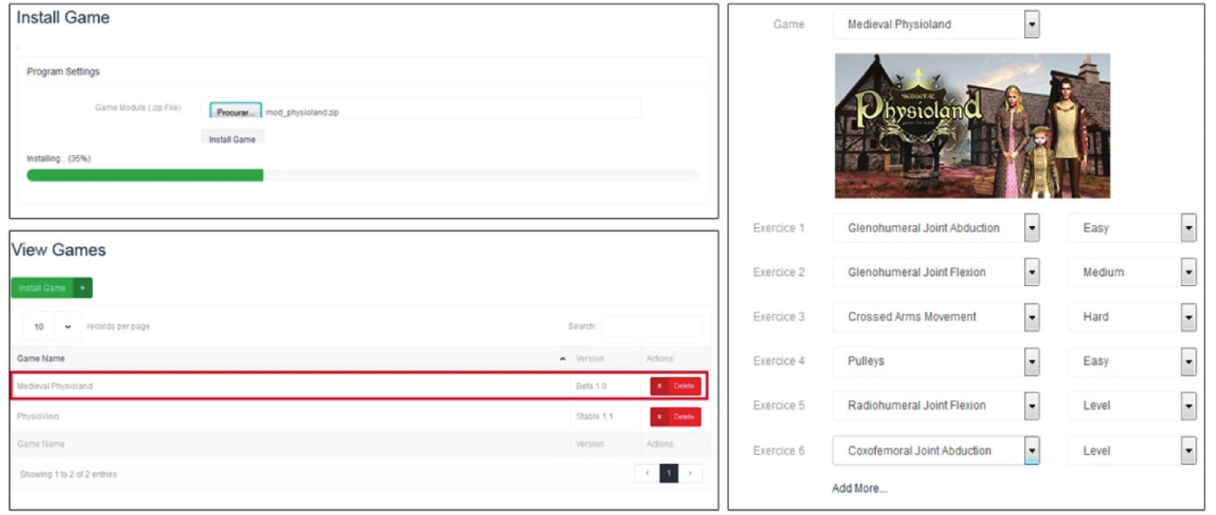
Figure 6: Process of installing a new game